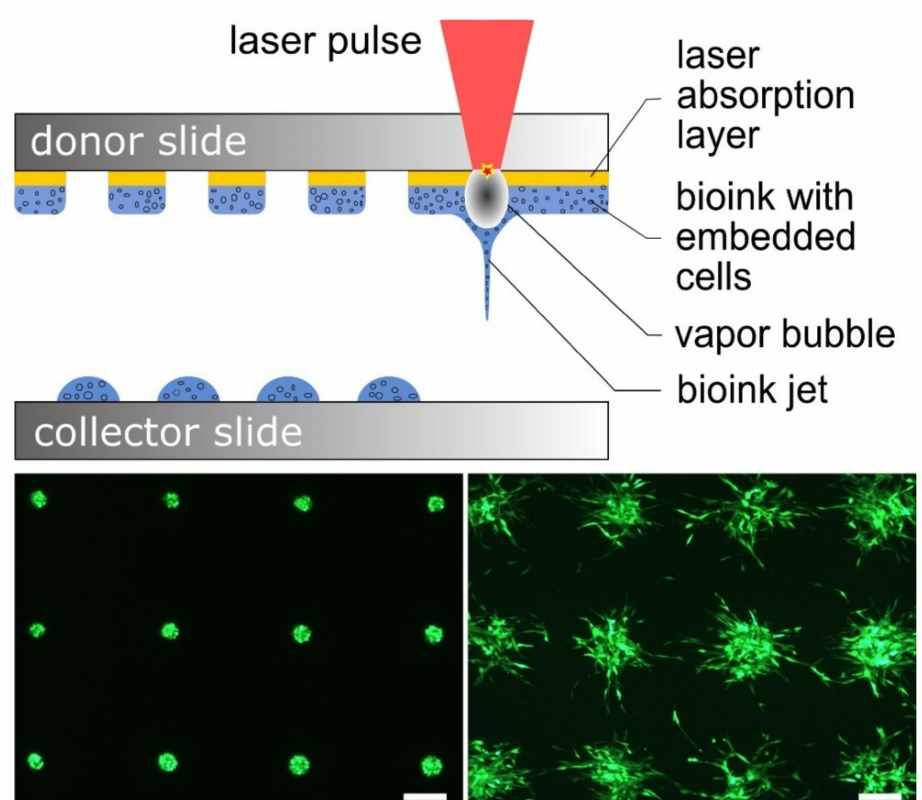
Figure 1. The laser bioprinting technique. Top: Schematic representation of laser-based bioprint- ing; in the focus, the laser pulses vaporize material of an absorption layer located between a glass plate and the bioink with dissociated cells. The vapor pressure temporarily creates a vapor bubble that expels the underlying bioink as a jet. The bioink settles as drops on a collector slide or other object to be printed onto. Bottom: Microscopic images of fluorescent cells (NIH/3T3 murine fibrob- lasts, GFP-labeled, printed on Matrigel; distance between droplets is 600 µ m) immediately after printing ( left ) and after two days ( right ); the behavior of the cells after printing depends on the cell type and many other factors, and must be considered in a printing strategy. The fibroblasts depicted here behave very differently on Matrigel compared to the endothelial cells used in this study. Scale bars are 200 µ